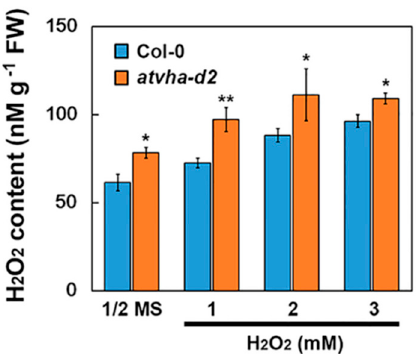
Figure 7. H 2 O 2 content in Col-0 and atvha-d2 mutant seedlings treated in 1/2 MS and 1/2 MS medium with H 2 O 2 (1, 2, and 3 mM) for 48 h. Asterisks indicate a significant difference between Clo-0 and atvha-d2 plants (* p < 0.05; ** p < 0.01; Student’s t- test). Error bars represent the SE ( n = 3).